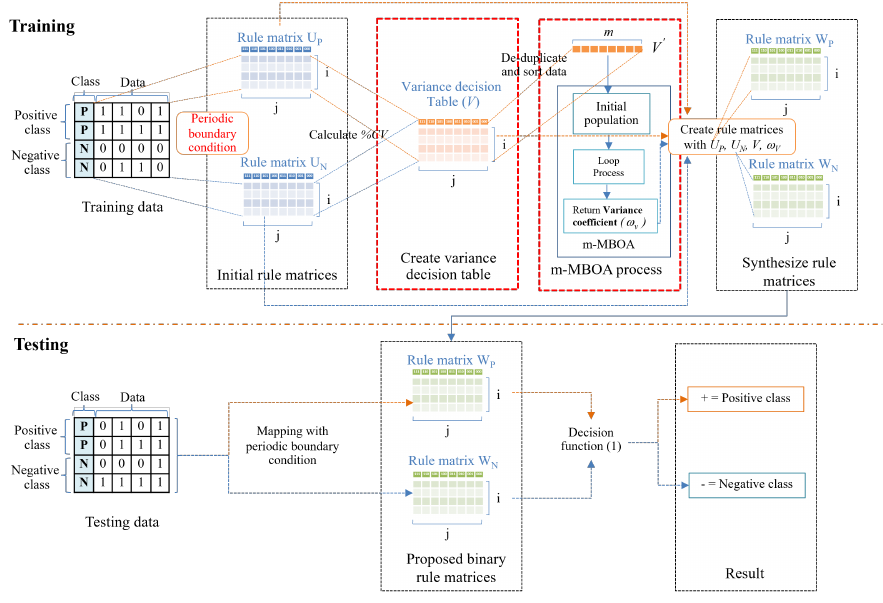
Figure 2. An overview of the proposed CAV